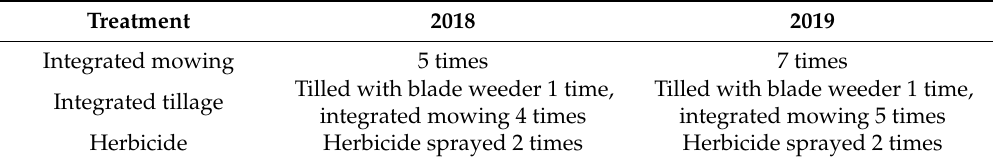
Table 1. Treatments applied in the tree row over 2 years